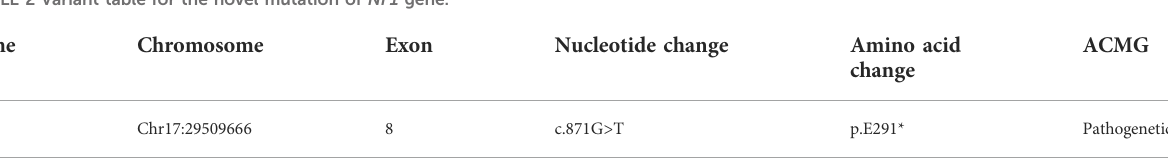
TABLE 2 Variant table for the novel mutation of NF1